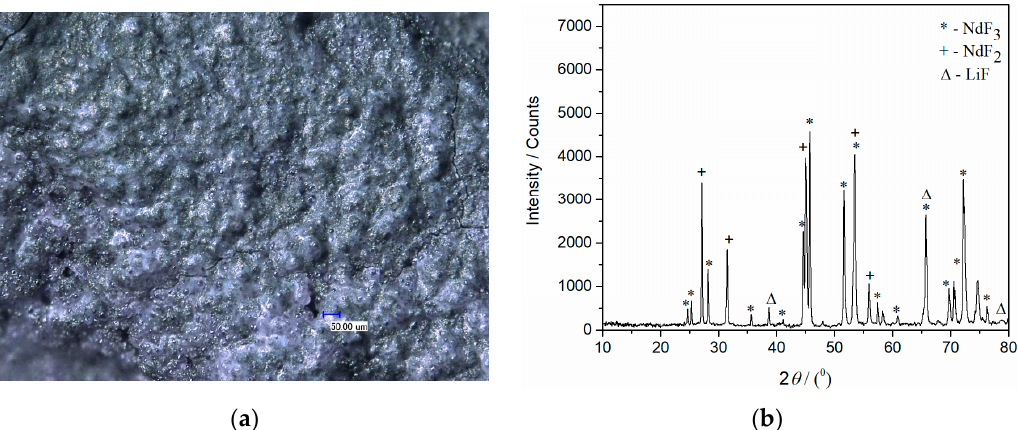
Figure 8 . ( a ) Optical image of the Mo WE with closely attached electrolyte after deposition at − 0.80 V for 7200 s, in molten NdF 3 –LiF–Nd 2 O 3 electrolyte system, at 1323 K (200×); ( b ) XRD spectra of the electrolyte layer on the Mo electrode from Figure 8a.